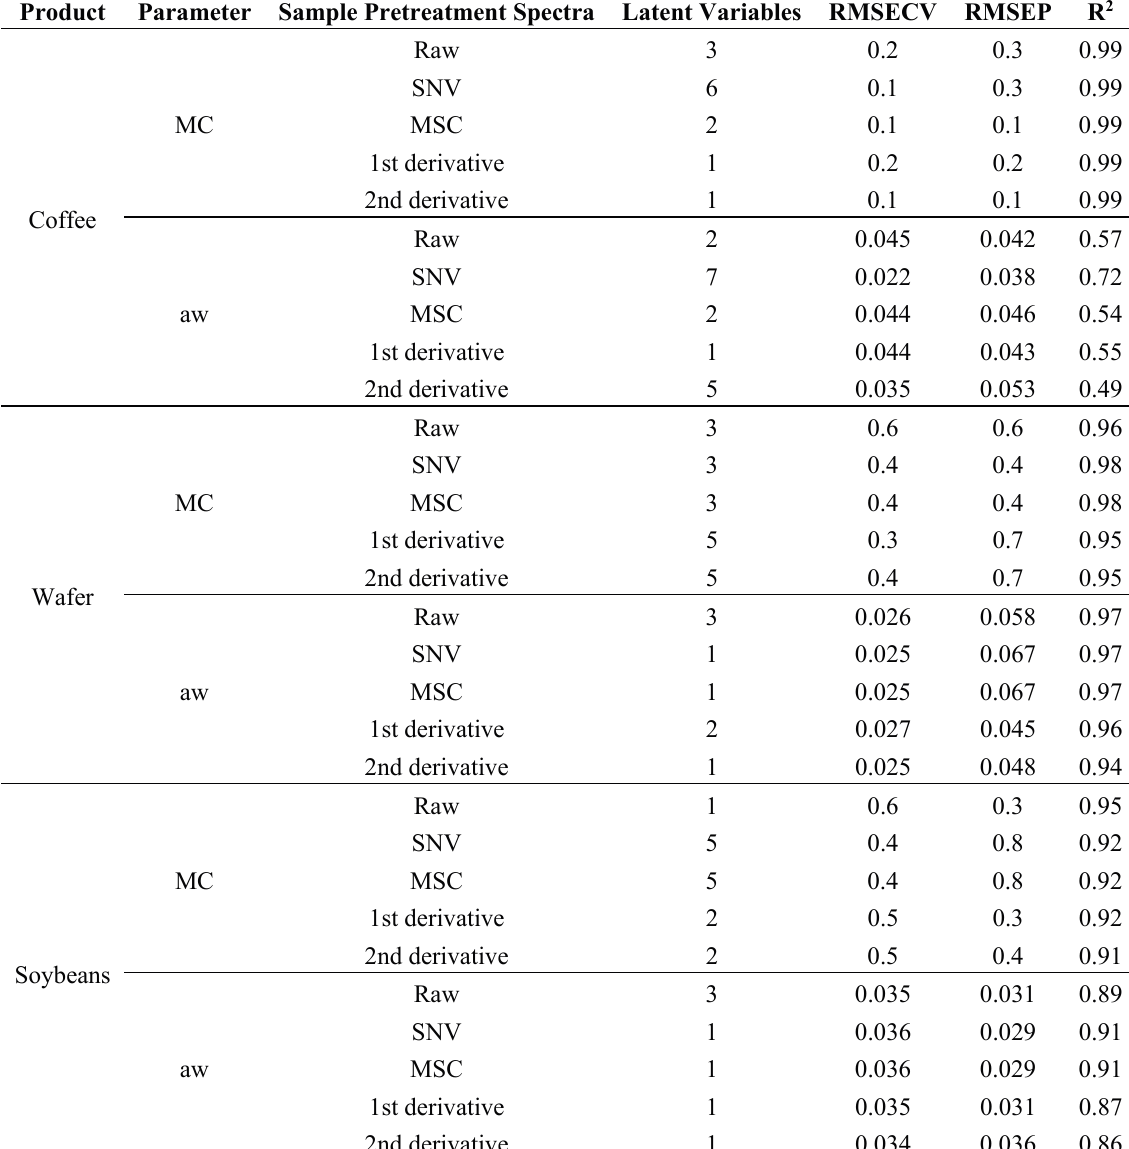
Table 2. Prediction of moisture content and aw using different